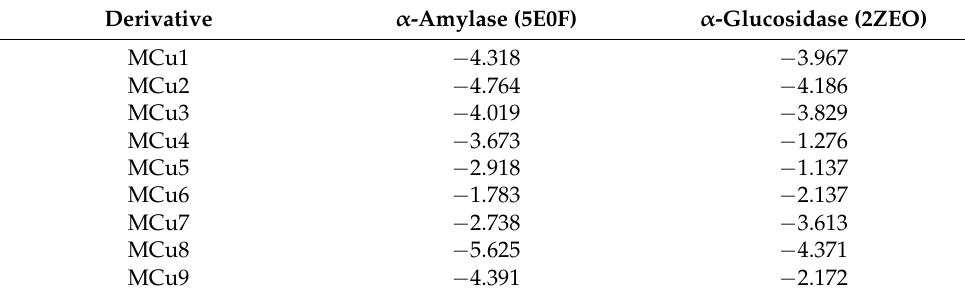
Table 11. Docking scores of metformin metal complex